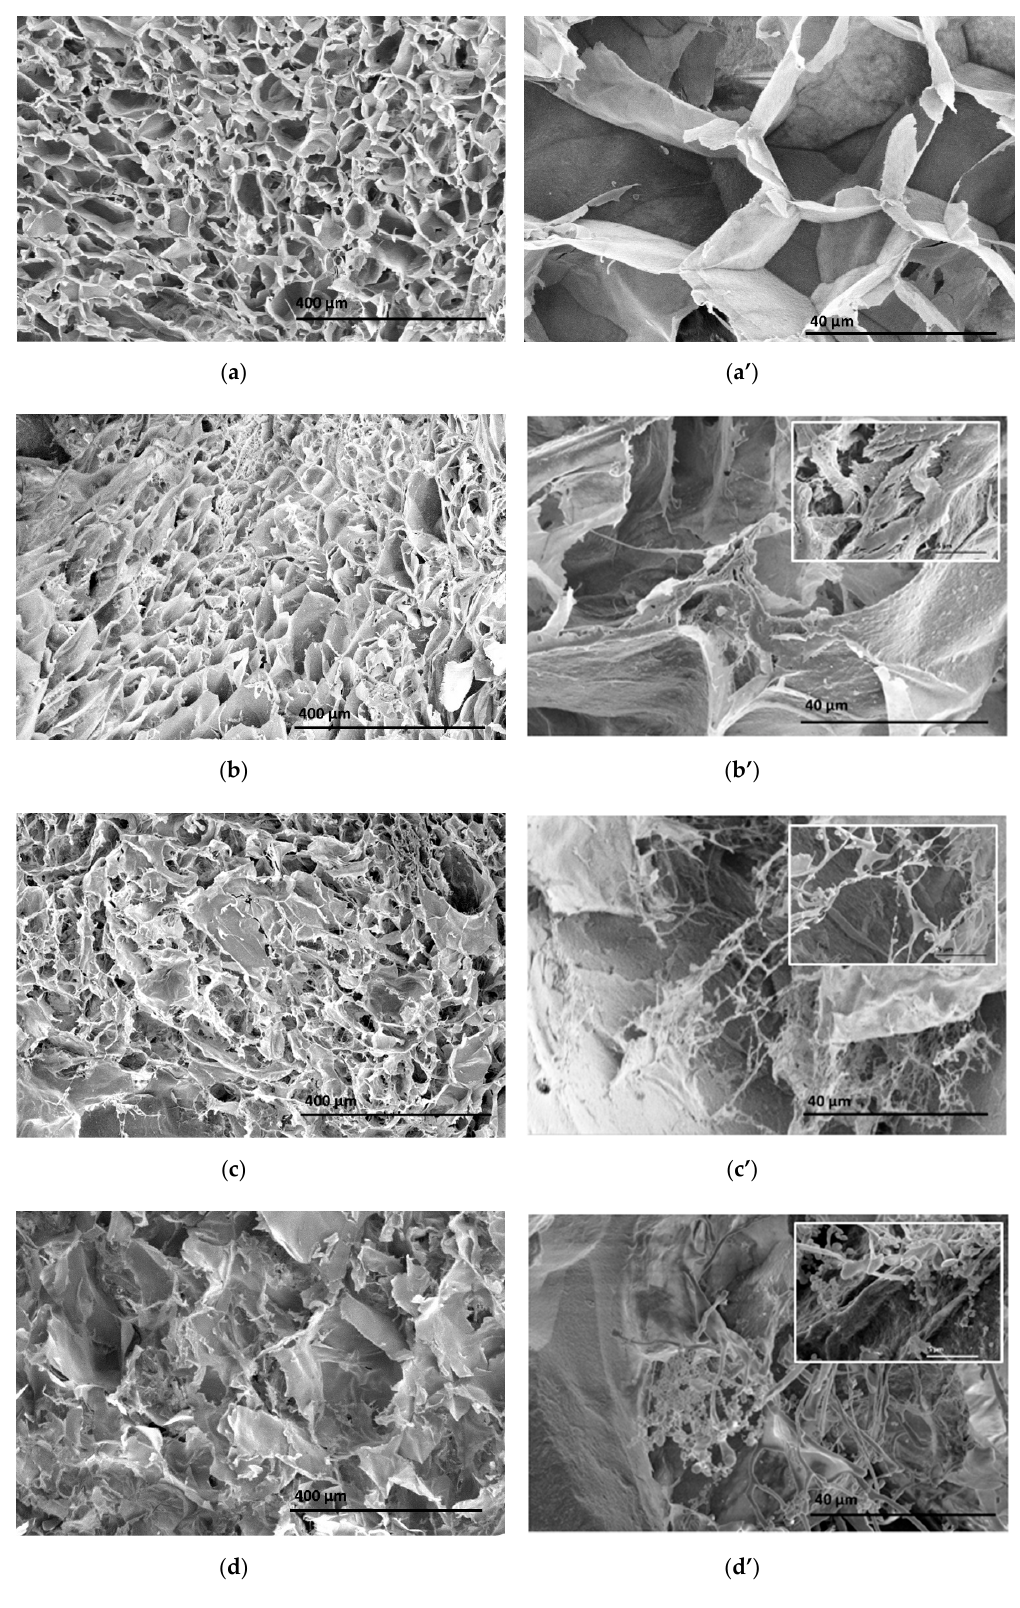
Figure 2. FE-SEM micrographs at 200x, 2000x and 10,000x (shown in inset) for prepared ACB hybrid hydrogels ( a , a’ ) ACB0, ( b , b’ ) ACB12.5, ( c , c’ ) ACB25 and ( d , d’ ) ACB50 (BCF agglomerate marked with white dashed